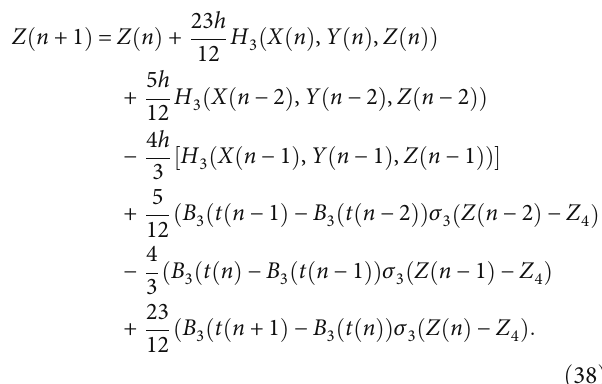
= 0 : 9 , c = 0 : 65 , c = 0 : 21 , c = 0 : 55 , c = 0 : 52 , c = 0 : 39 , c 1 2 3 4 5 6 7